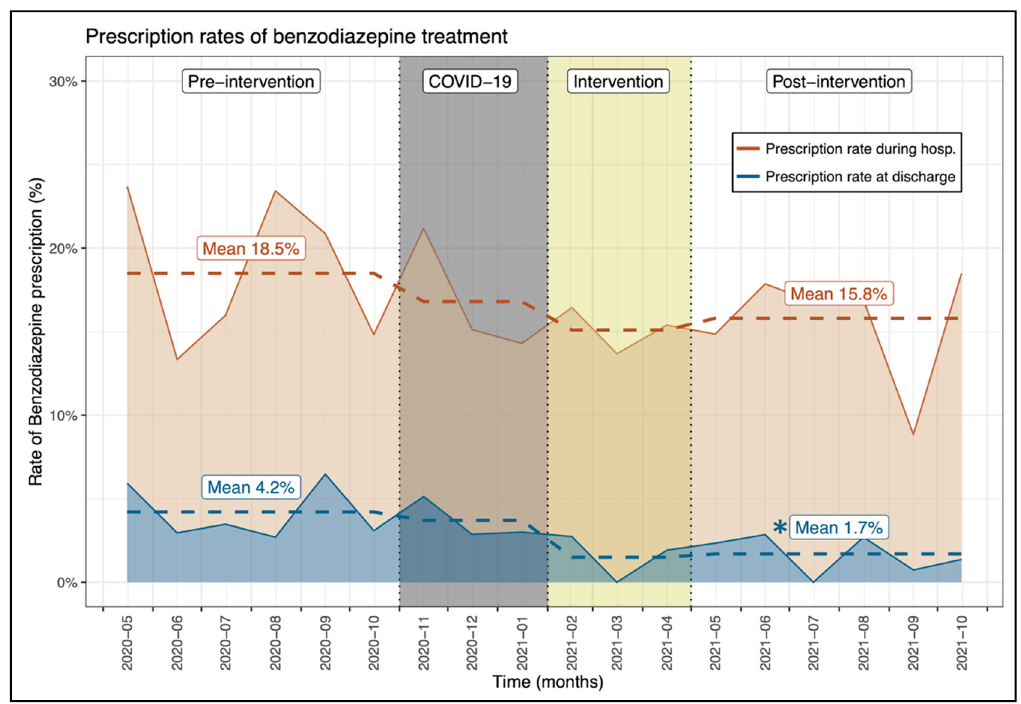
Figure 2. Evolution of the proportion of patients with a benzodiazepine prescription between the investigated periods. * Indicates a significant difference between the pre- and post-intervention prescription rate.